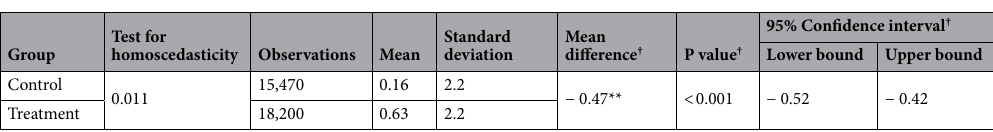
Table 3. Statistical comparison for the T1–T0 difference in VAS scores from all the observers between the Treatment group and the Control group. **Statistically significant with p < 0.01; † Values from independent samples T-test with Satterthwaite’s correction for the lack of homoscedasticity.